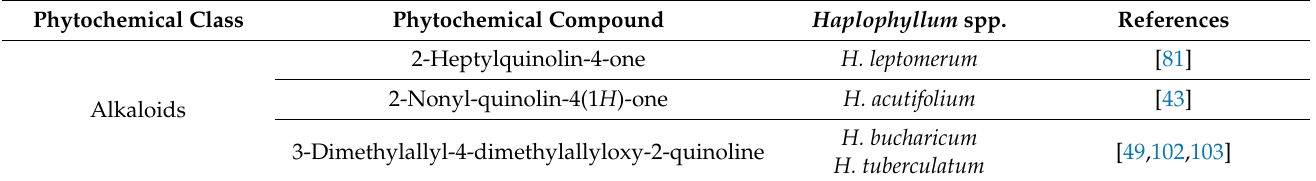
Table 4. Distribution of the non-volatile phytochemicals in the Haplophyllum genus. Phytochemical Class Phytochemical Compound Haplophyllum